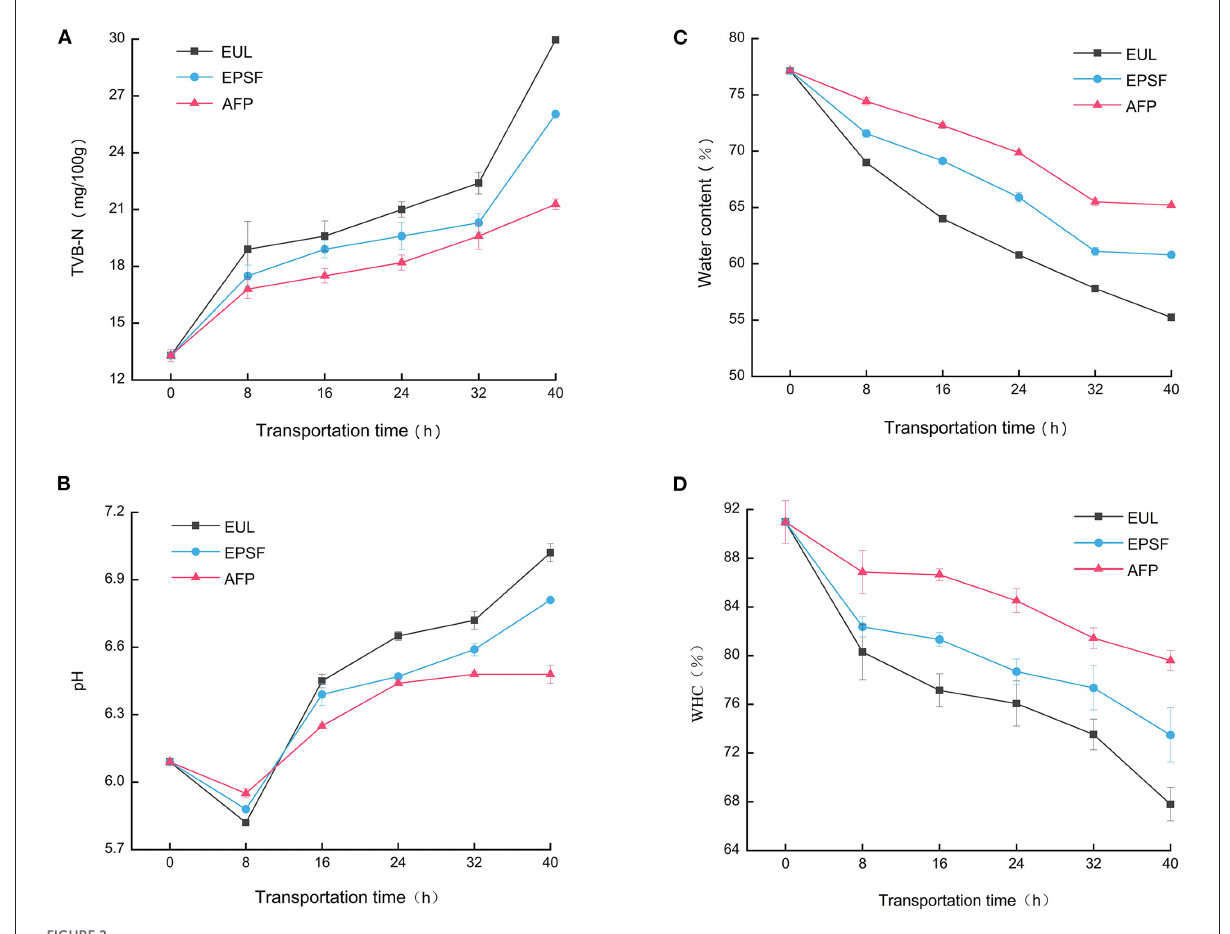
FIGURE2 Effects of various logistics packaging boxes on changes in the TVB-N (A) , pH (B) , water content (C) , and WHC (D) . EUL, European logistics; EPSF, expanded polystyrene foam; AFP, aluminum foil paper; WHC, water holding capacity. Data were obtained as the mean ± standard deviation ( n =